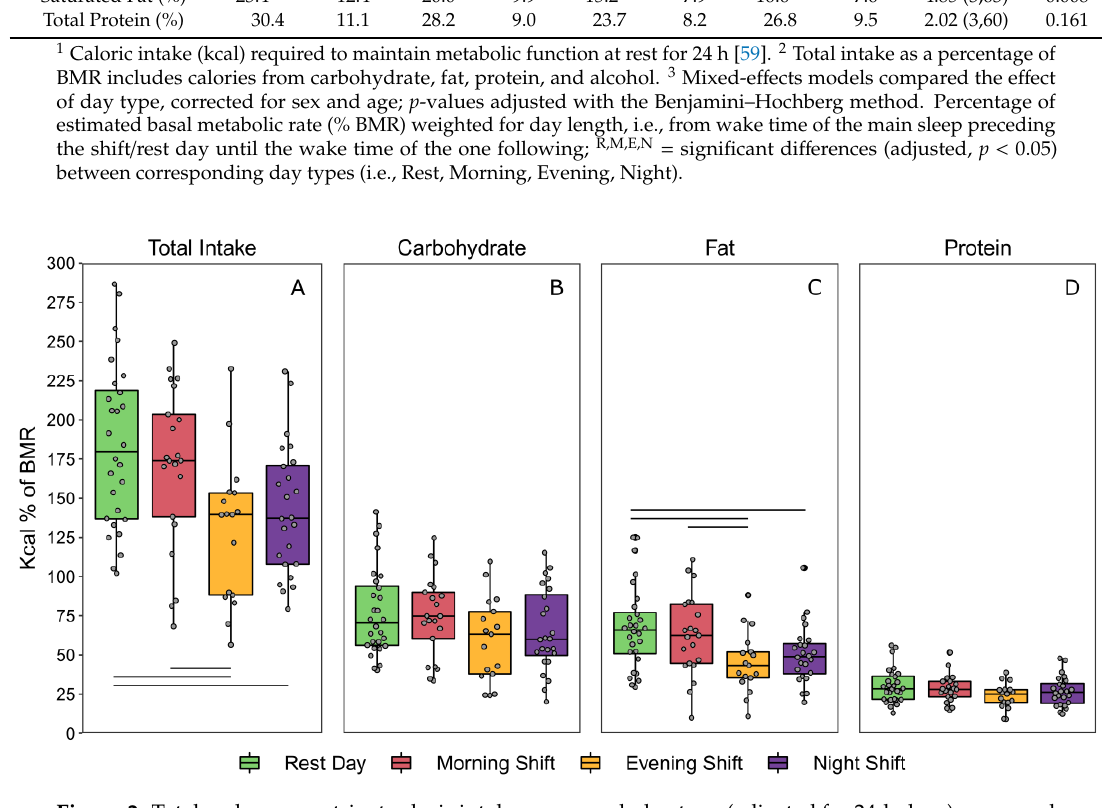
Figure 2. Total and macronutrient caloric intake across each day type (adjusted for 24-h days) expressed as percentages of basal metabolic rate (% BMR). Boxplots depict the median and interquartile ranges of total % BMR from ( A ) all calories, ( B ) carbohydrates, ( C ) fats, and ( D ) proteins. Horizontal lines represent significant differences (adjusted, p < 0. 05) between day types relative to metabolic requirements.